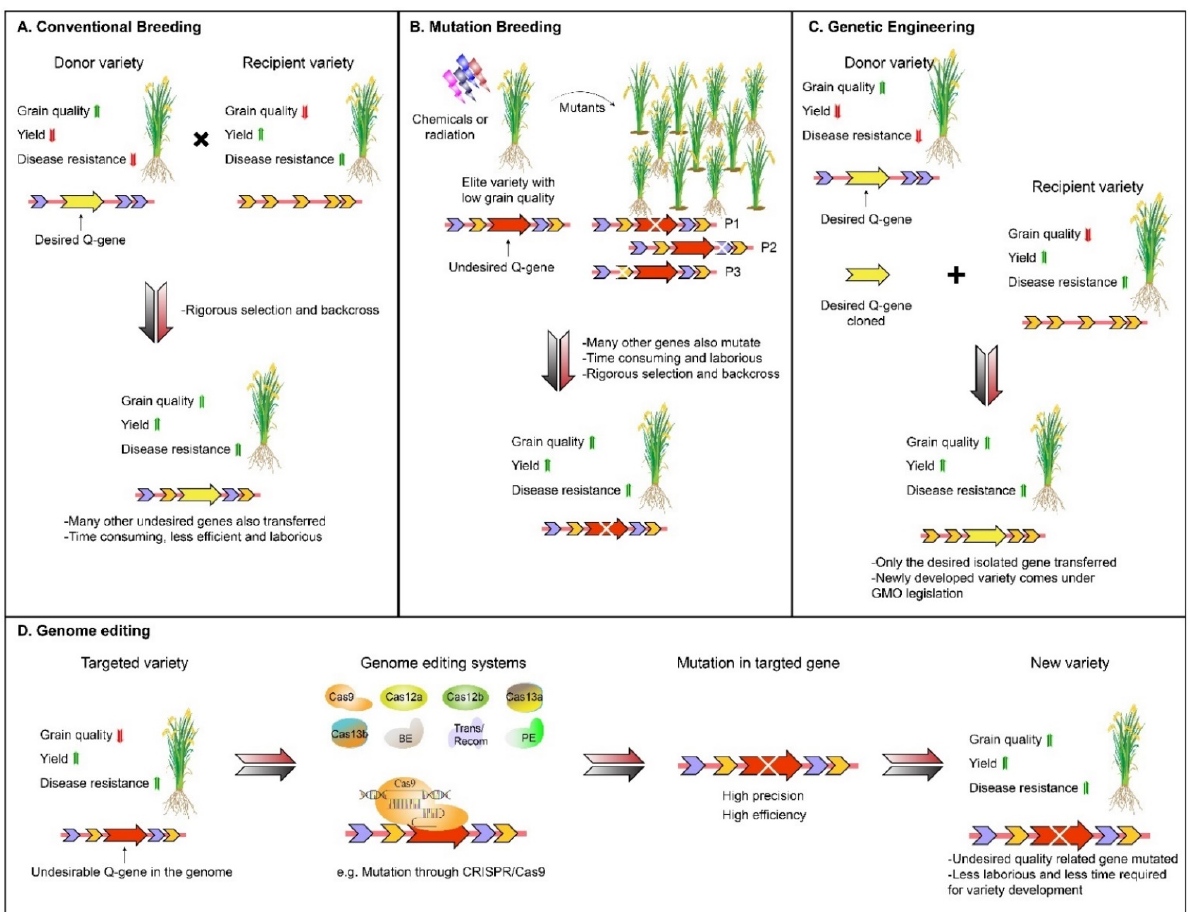
Figure 1. Overview of plant breeding approaches for developing rice varieties with improved yield, stress tolerance and grain quality. ( A ) Conventional breeding for crop improvement, e.g., rice grain quality improvement. ( B ) Mutational breeding approach for rice grain quality improvement. ( C ) Genetic engineering for incorporating the desired gene in popular rice variety. ( D ) Application of gene editing tools for rice plant improvement, e.g., targeting rice grain quality sensitive genes via CRISPR/Cas systems. Upward green arrow shows improved or high grain quality/yield/disease resistance in the plant. Downward red arrow shows deprived or low grain quality/yield/disease resistance in the plant. Q-gene, Quality gene; Cas9, CRISPR-associated protein 9; Cas12a, CRISPR-associated protein 12a; Cas12b, CRISPR-associated protein 12b; Cas13a, CRISPR-associated protein 13a; Cas13b, CRISPR-associated protein 13b; BE, Base Editors; Trans/Recom, Transposases or Recombinases; PE, Prime Editors.